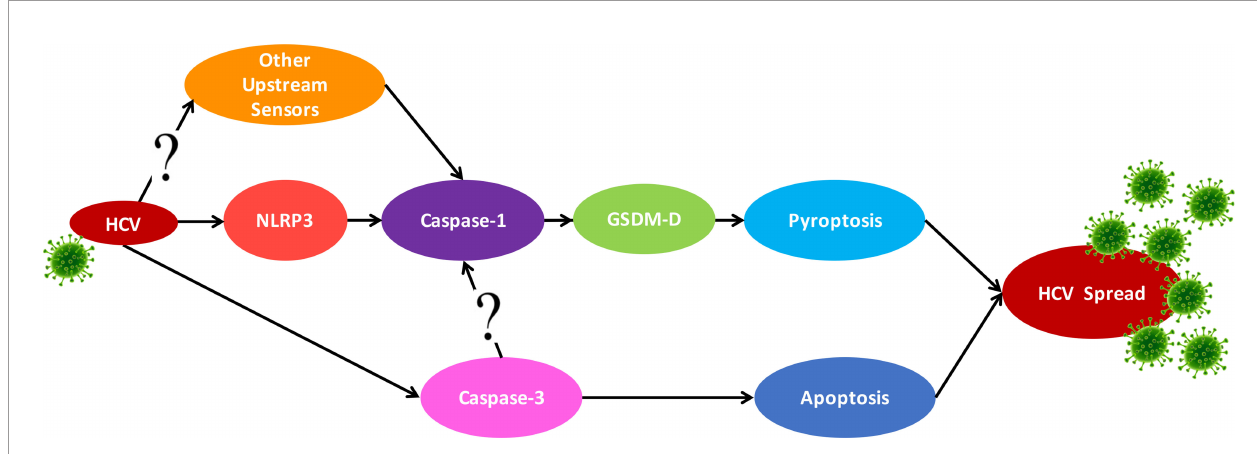
FIGURE 7 | Proposed crosstalk between the apoptosis and pyroptosis pathways. Schematic for the proposed crosstalk between the apoptosis and pyroptosis pathways and how they may contribute to HCV spread. HCV infection can trigger pyroptosis via the NLRP3 in fl ammasome pathway but likely also triggers in fl ammasome formation with other sensors. Apoptosis is also activated in the presence of HCV but this is reduced when pyroptosis is